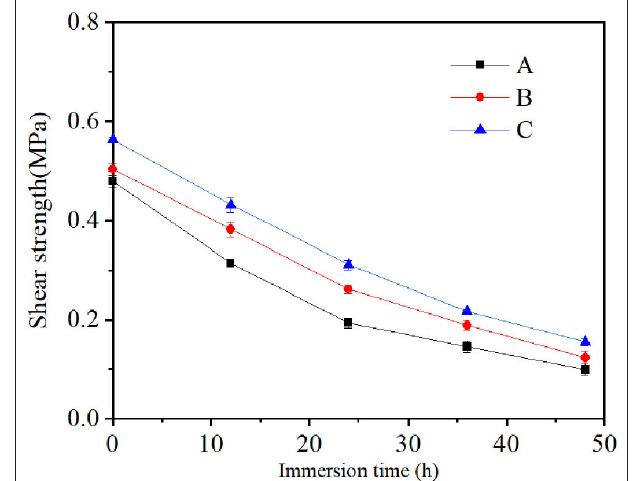
FIGURE 4 | Interfacial shear strength at different temperatures.